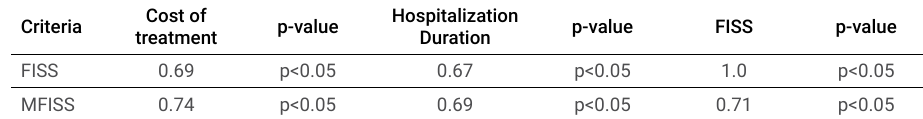
Table 2. Correlation level between FISS, MFISS, hospitalization duration and cost of treatment